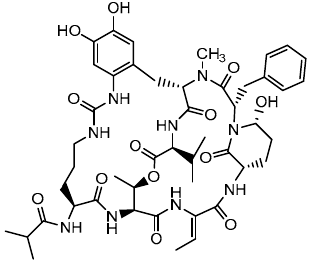
Figure 10. Structure of FR901277.